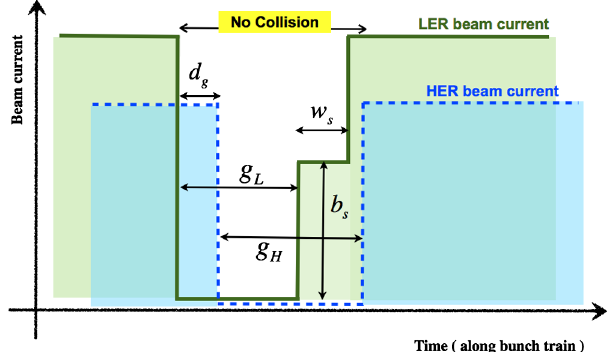
FIG. 15. Illustration of a bunch fill pattern for more effective mitigation. The bunch current at the leading part of the LER train is increased in two steps with a time interval w current at the first step by b LER and HER, respectively, and the HER gap is delayed by d